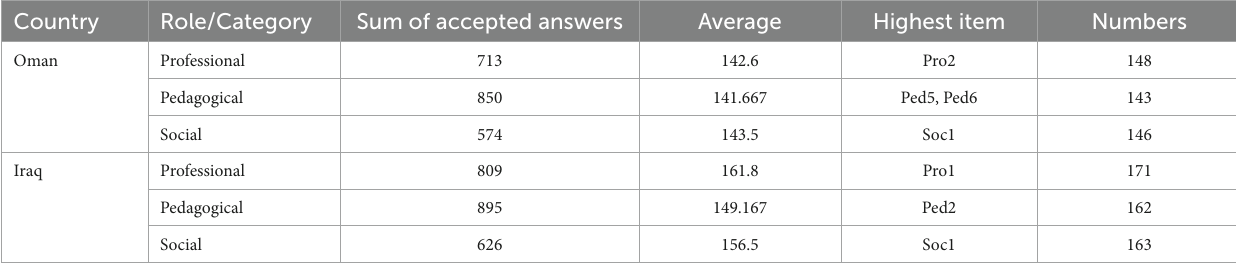
TABLE 10 Results analysis of three highest accepted roles.